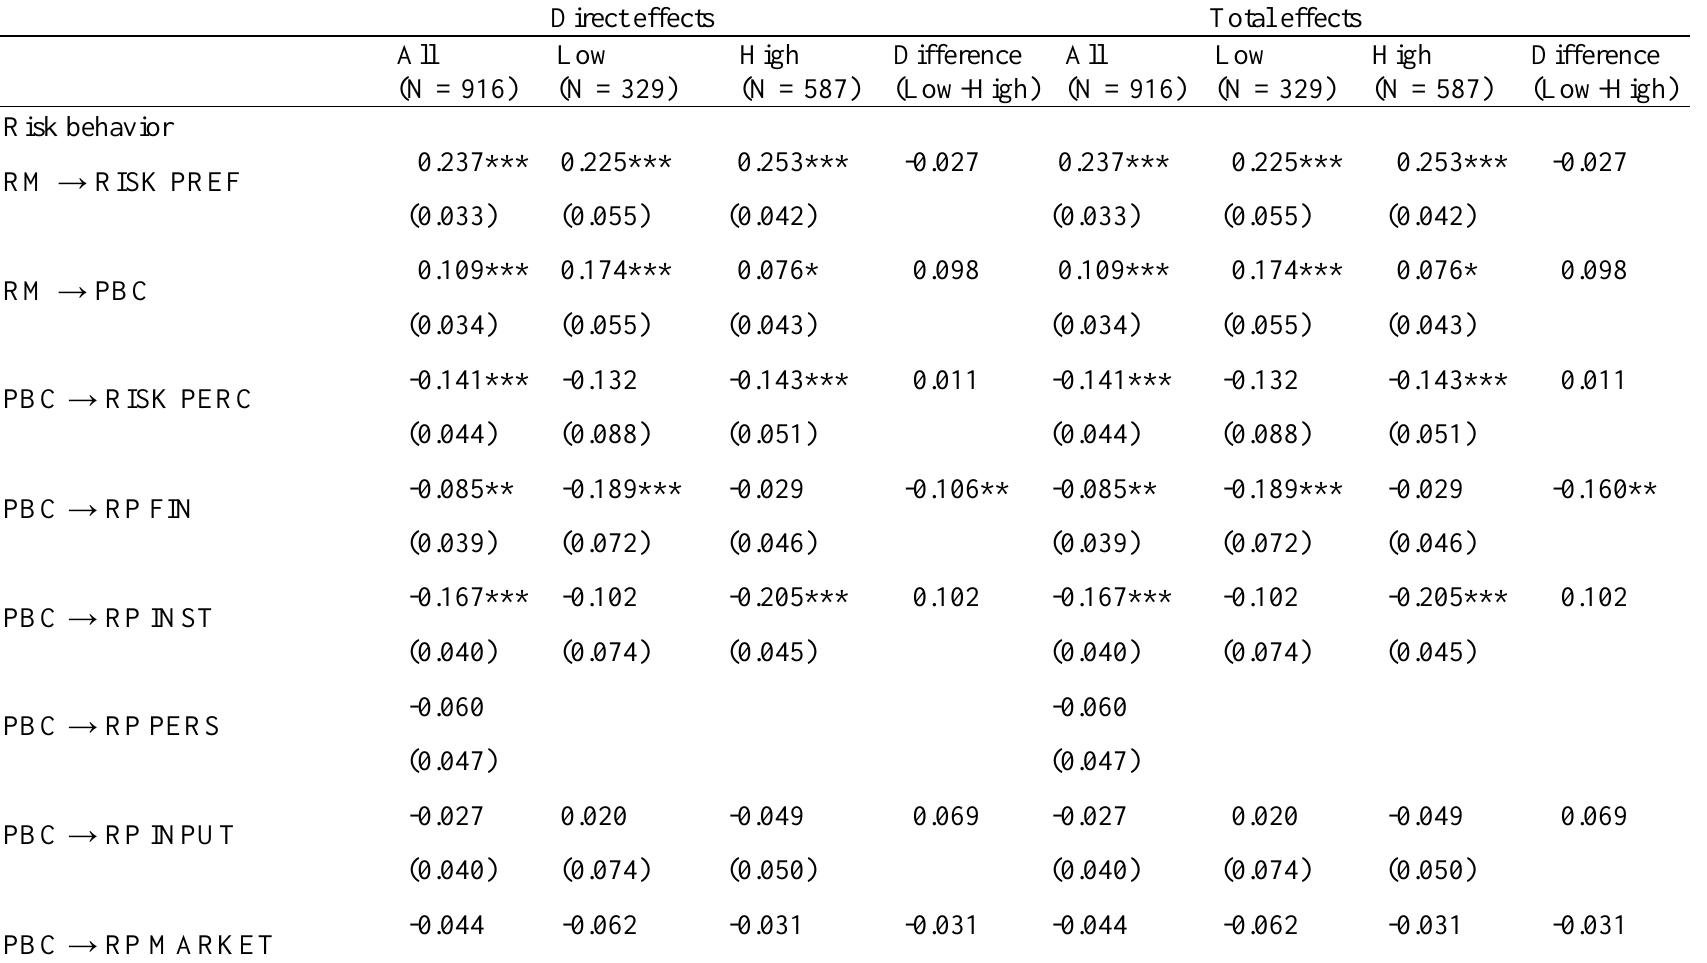
Table A1.10 . Path coefficients including domain-specific risk perceptions of the PLS-SEM. RP FIN = risk perception in the financial domain, RP INST = risk perception in the institutional domain, RP PERS = risk perception in the personal and personnel domain, RP INPUT = risk perception in the input price domain, RP MARKET = risk perception in the market price domain, RP PROD = risk perception in the production domian RP SC = risk perception in the supply chain domain, RP SOC = risk perception in the social